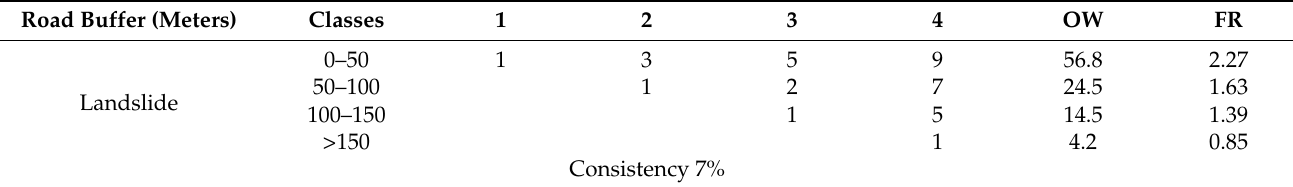
Figure 7. Curvature causative factor map. Table 9. AHP matrices and OWs for the road causative factor